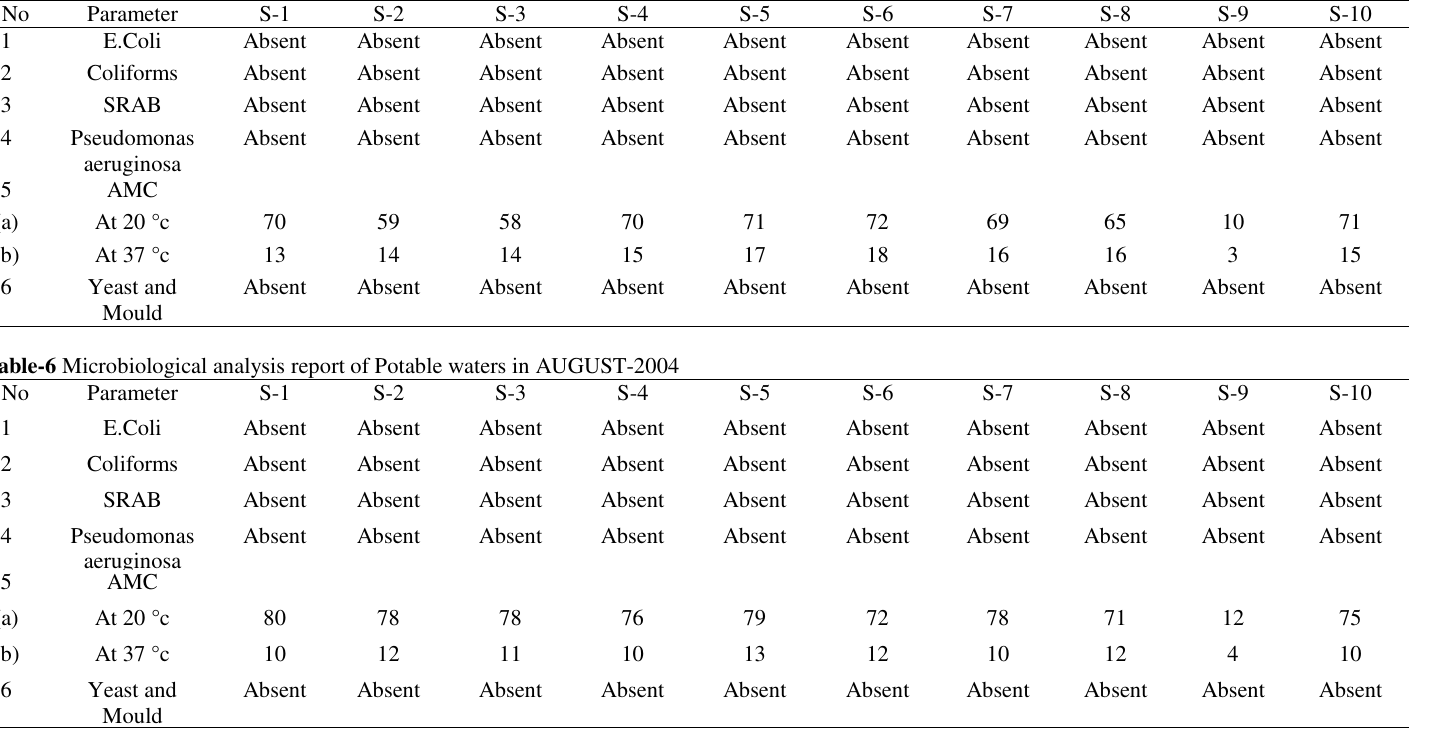
Table -5. Microbiological analysis report of Potable waters in MAY-2004 S.No